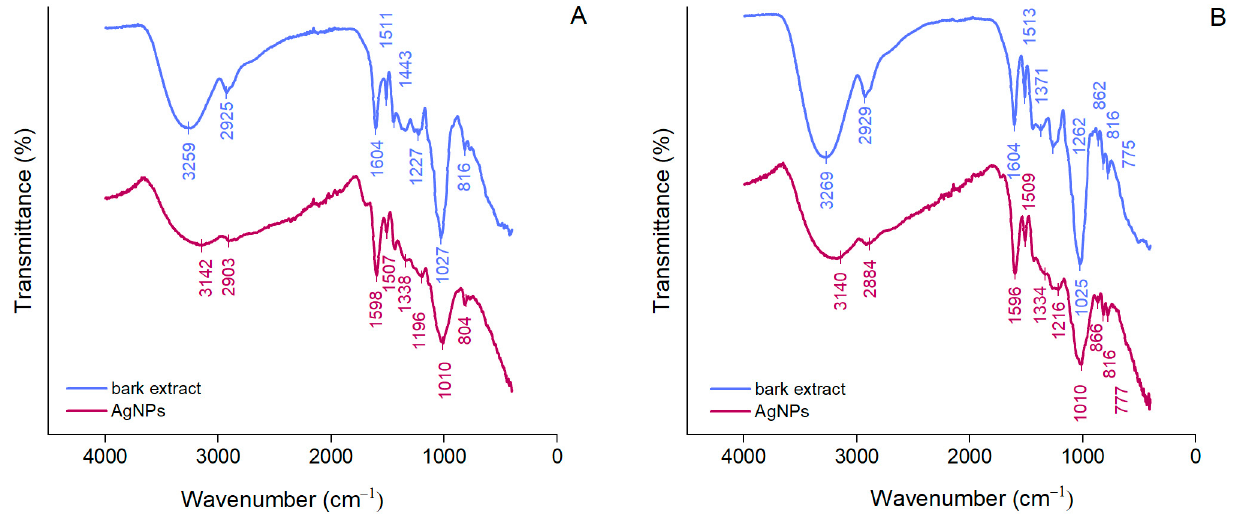
Figure 2. ATR-FTIR spectra of Abies alba ( A ) and Pinus sylvestris ( B ) bark aqueous extracts and their derived AgNPs.